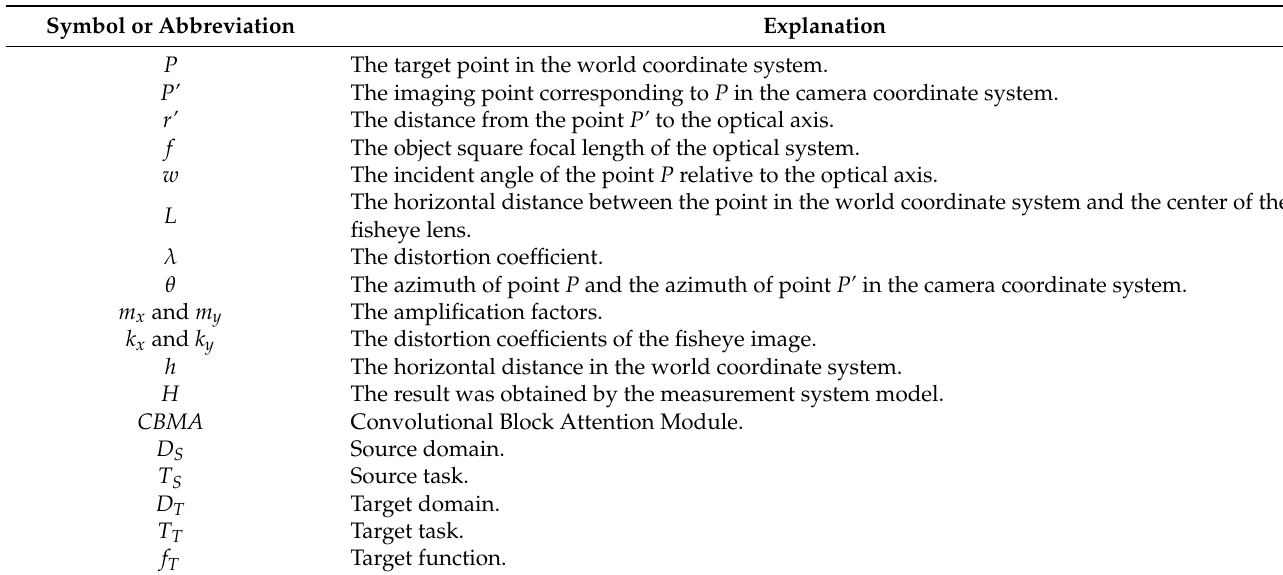
Table A1. Symbols and abbreviations which appear in the text.